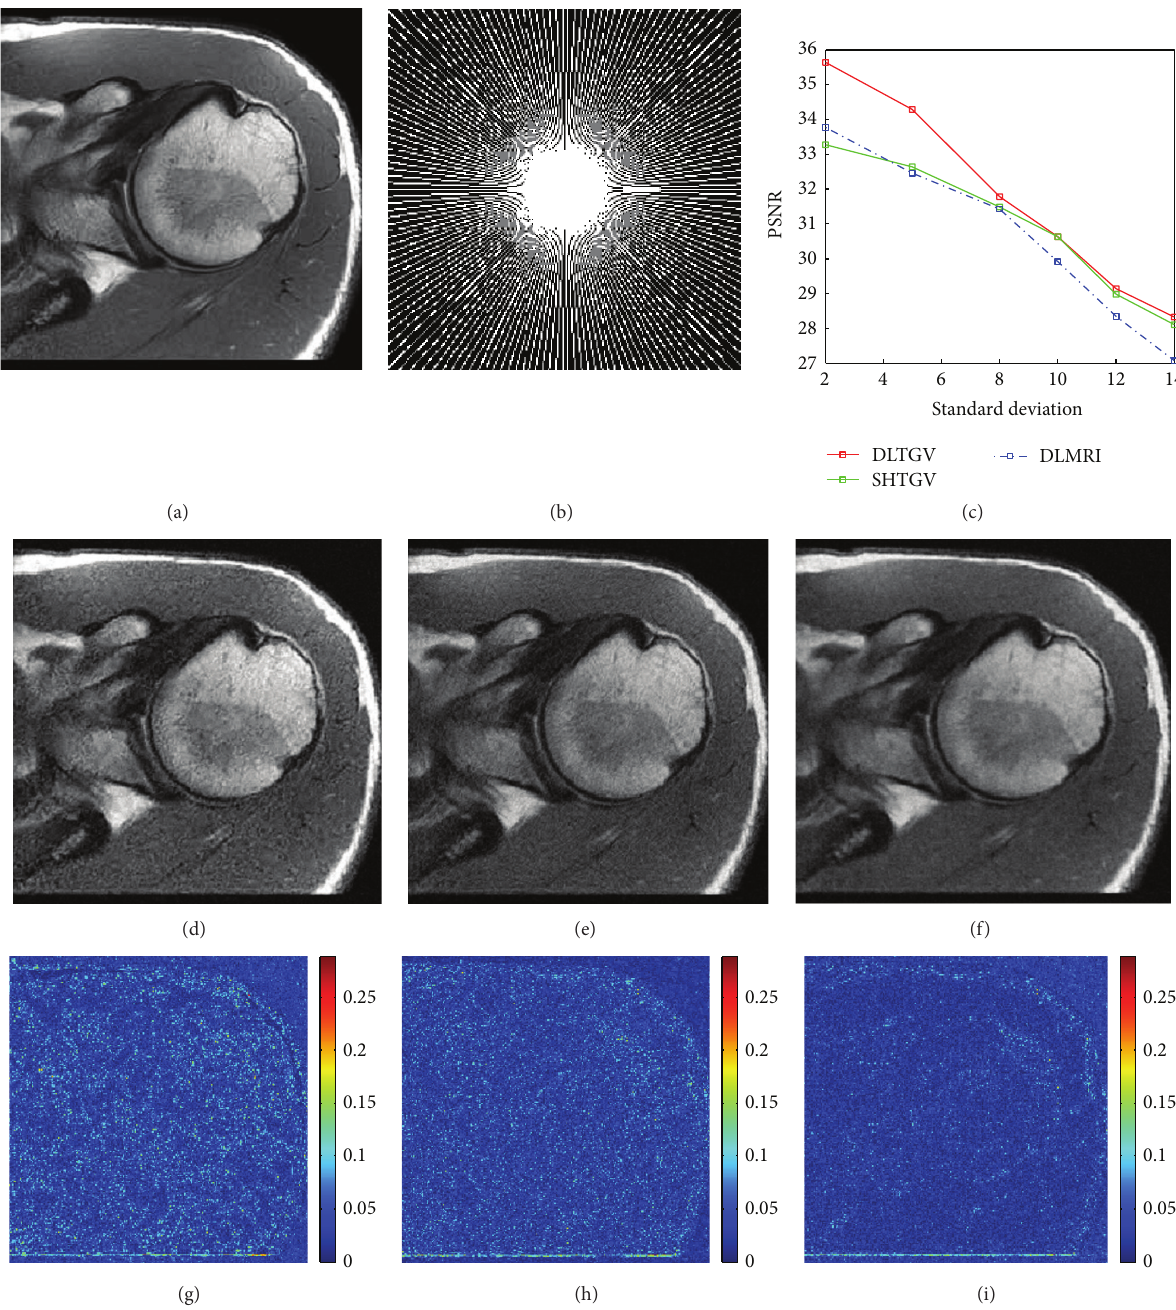
Figure 3: (a) Reference image. (b) Sampling mask in 𝑘 -space with 6.09-fold undersampling. (c) PSNR versus noise level for DLMRI, SHTGV, and DLTGV. ((d), (e), (f)) Reconstructed images using DLMRI, SHTGV, and DLTGV. ((g), (h), (i)) Reconstruction error magnitudes for DLMRI, SHTGV, and DLTGV with noise 𝜎 = 14